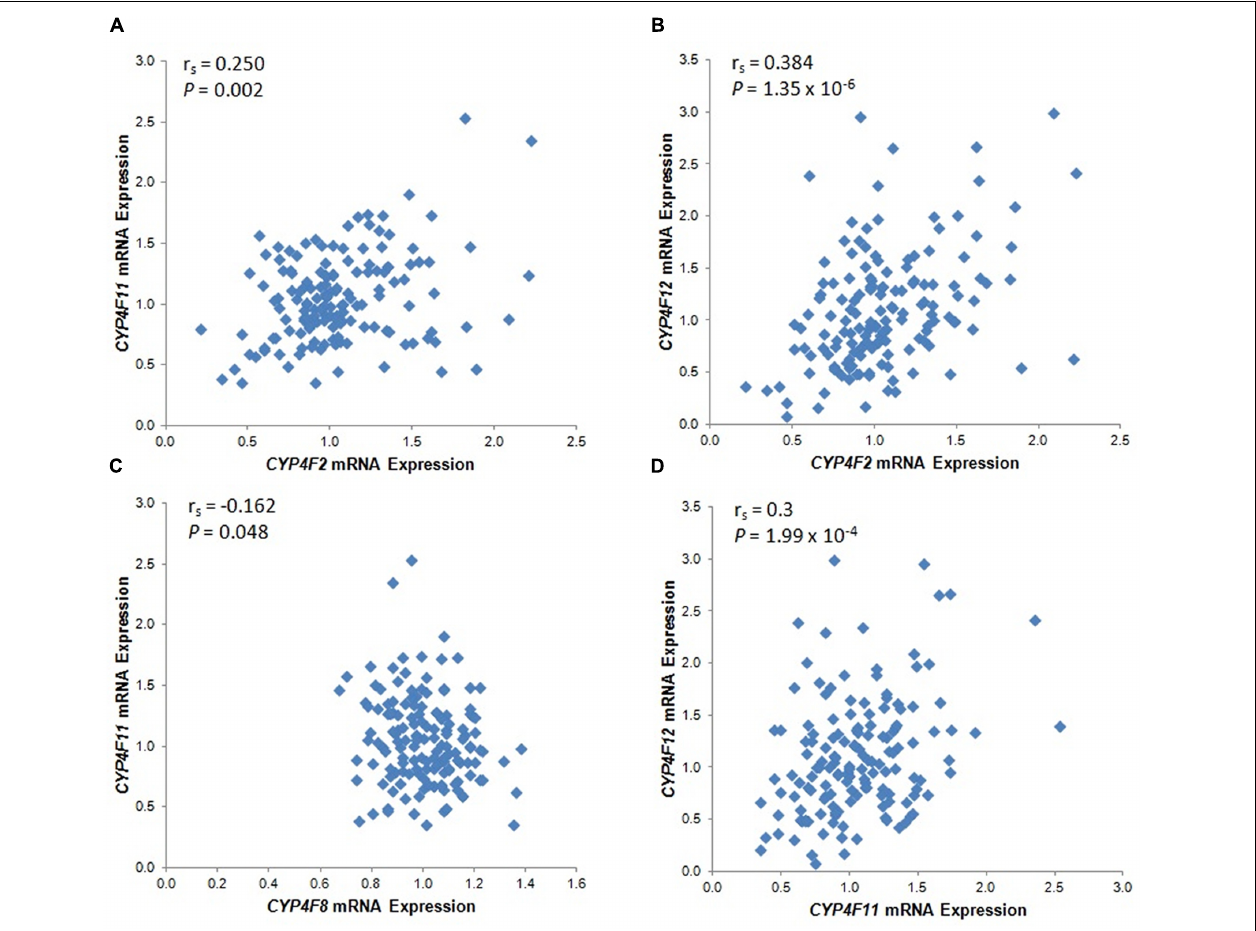
FIGURE 1 | Statistically significant CYP4F mRNA correlations in 149 Caucasian human liver tissues. (A) CYP4F2 vs. CYP4F11 ; (B) CYP4F2 vs. CYP4F12 ; (C) CYP4F8 vs. CYP4F11; (D) CYP4F11 vs. CYP4F12 . vs., versus. The Spearman’s rho correlation coefficient (r s ) and P -value for each comparison are given. Log2 transformed expression data are